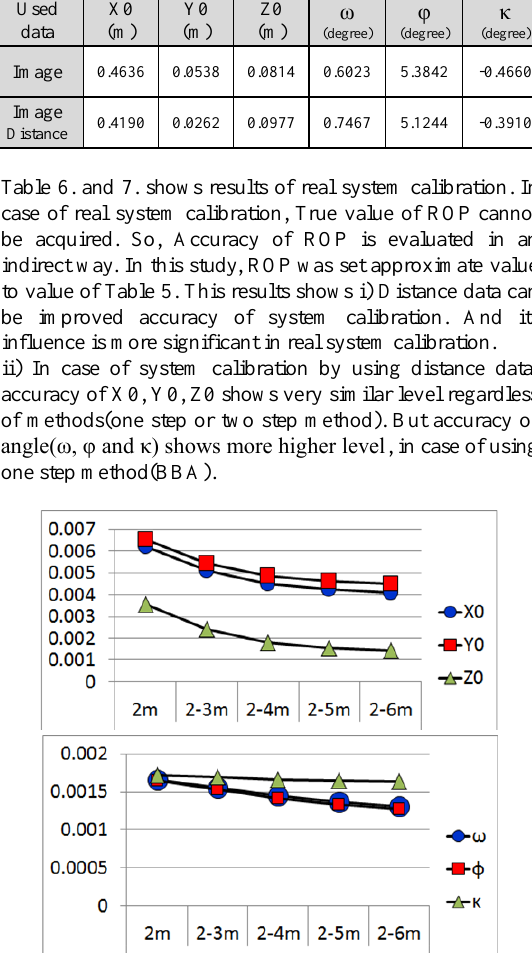
Figure 12. Standard deviation (one step method, piling image) Figure 12. shows standard deviation of ROP in case of